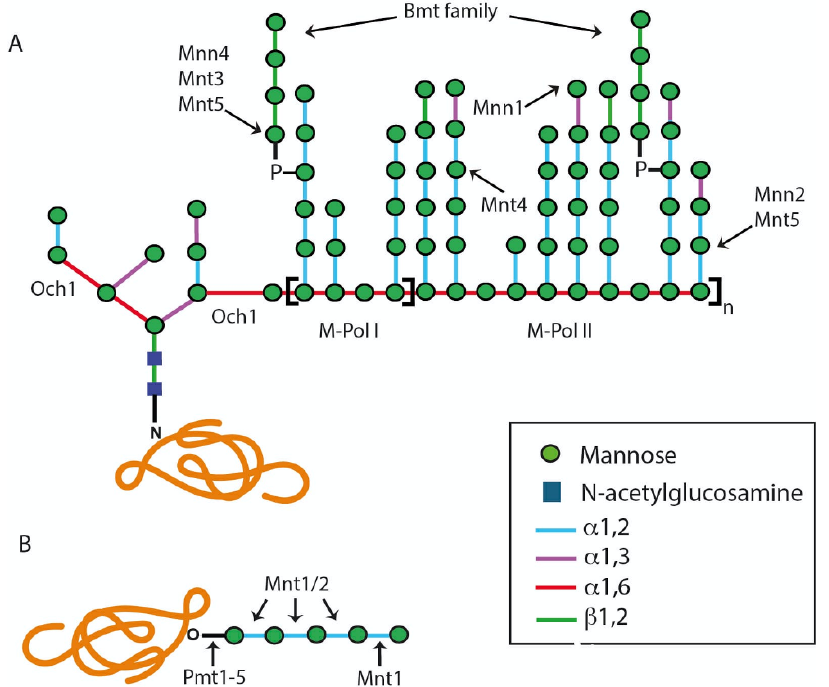
Figure 1. Schematic diagram representing the Candida albicans N -linked and O -linked glycans. ( A ) N -linked glycan. The outer chain elaboration begins with the addition of an α -1,6-mannose residue to the N -linked glycan core by the α -1,6-mannosyltransferase Och1. Then, an α -1,6-mannose backbone is synthesized by M-Pol I and M-Pol II complexes, and this is branched with α -1,2-mannooligomers that can be decorated with phosphomannan, β -1,2-mannose, or α -1,3-mannose units. ( B ) O -linked glycan. The addition of the first mannose residue is initiated in the endoplasmic reticulum by protein mannosyltransferases encoded by the PMT gene family. The glycoprotein is then transported to the Golgi complex for the addition of further mannose residues by mannosyltransferases Mnt1 and Mnt2.